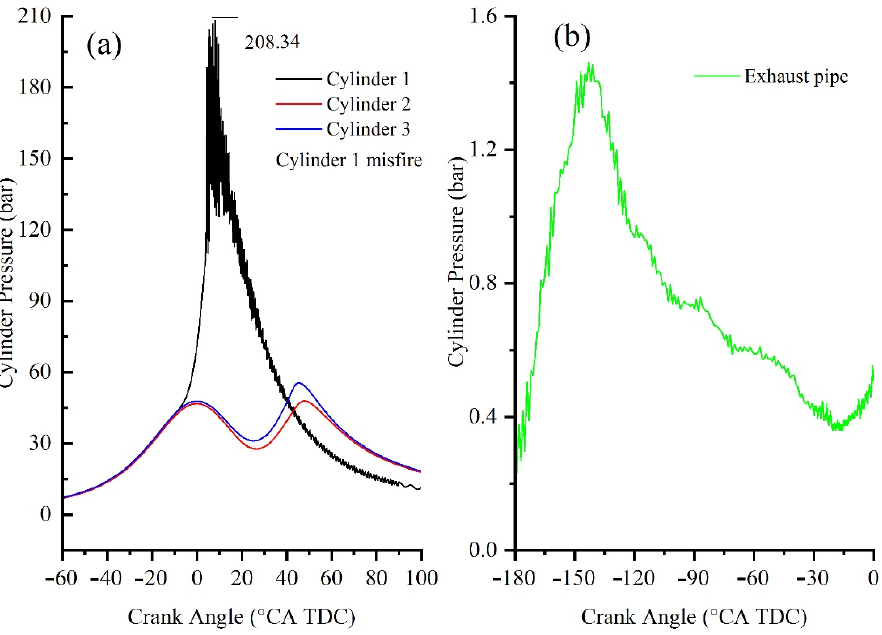
Figure 19. The exhaust pressure and in-cylinder pressure curves with super-knock in cylinder 1: ( a ) the pressure in the exhaust pipe; ( b ) the pressure in cylinders.